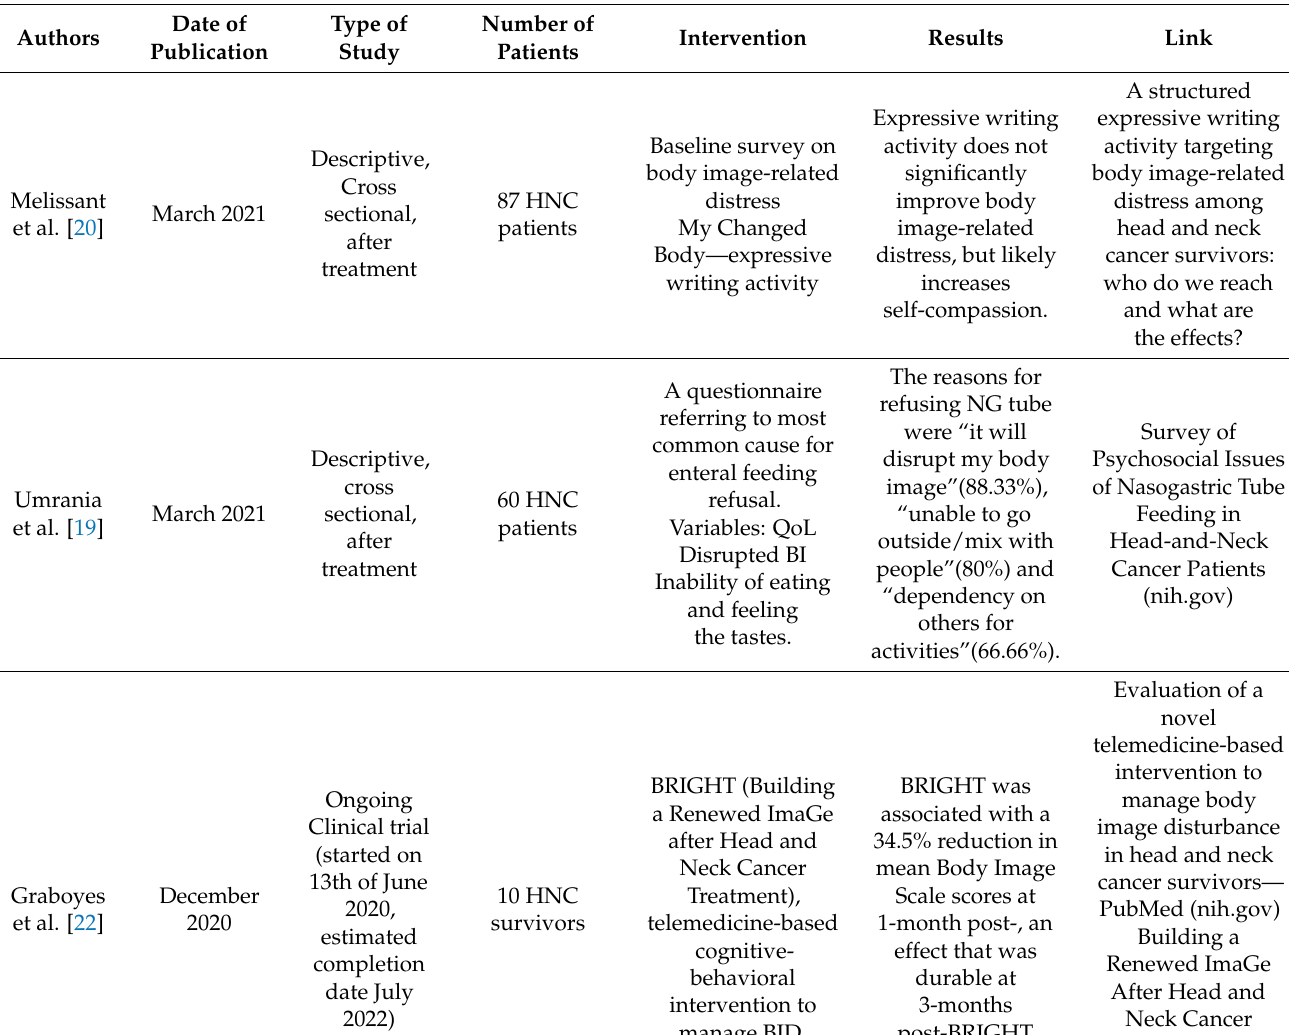
Table 3. Specific interventions to improve body image and quality of life in people with head and neck